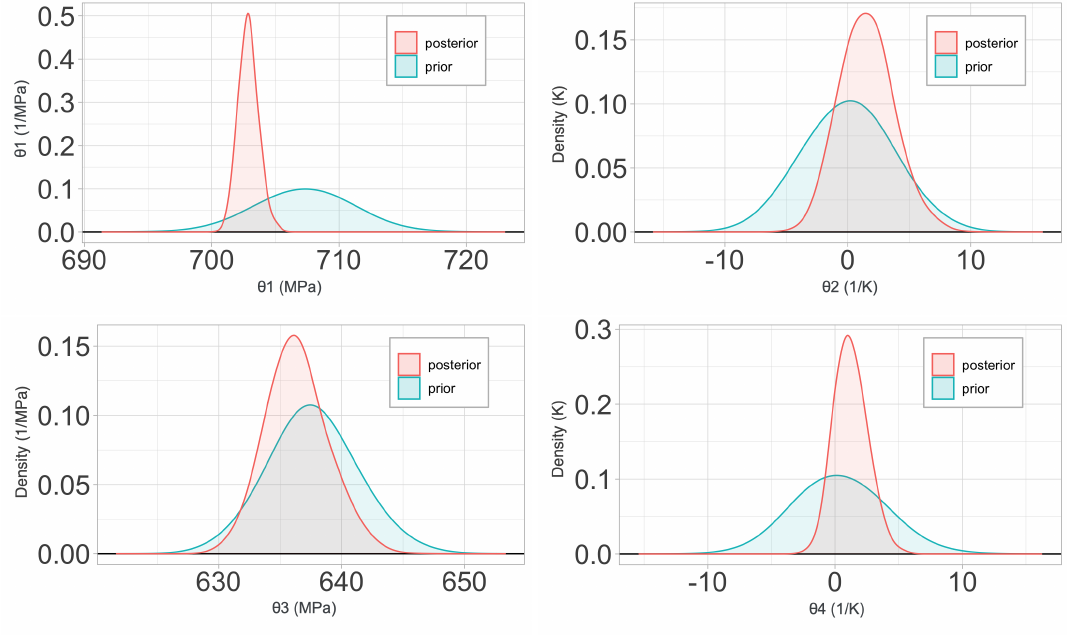
Figure 16. Prior vs. posterior parameter probability distributions for C 0 ∼ θ 1 , C 3 ∼ θ 2 , C 5 ∼ θ 3 , n ∼ θ 4 , of the ZA model considering ∆ L as the QoI.